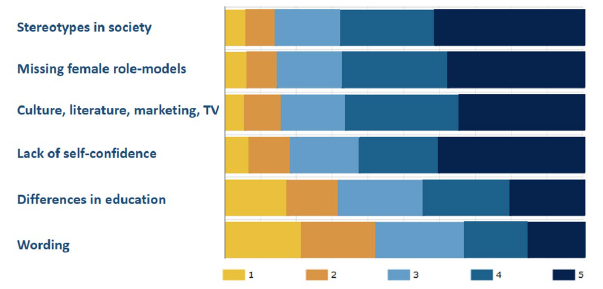
Figure 4. Barriers choosing STEM education